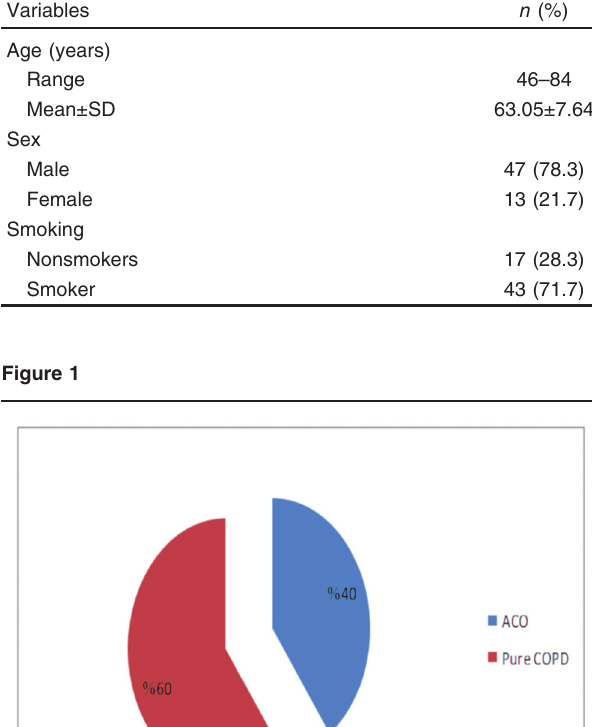
Table 1 Demographic data of the patients with chronic obstructive pulmonary disease Variables